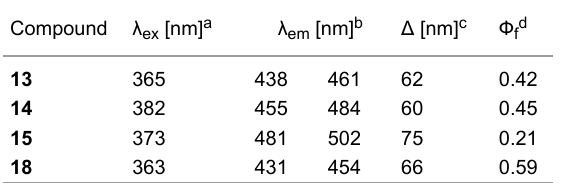
Table 2: Fluorescence spectral parameters of investigated donor–acceptor–donor